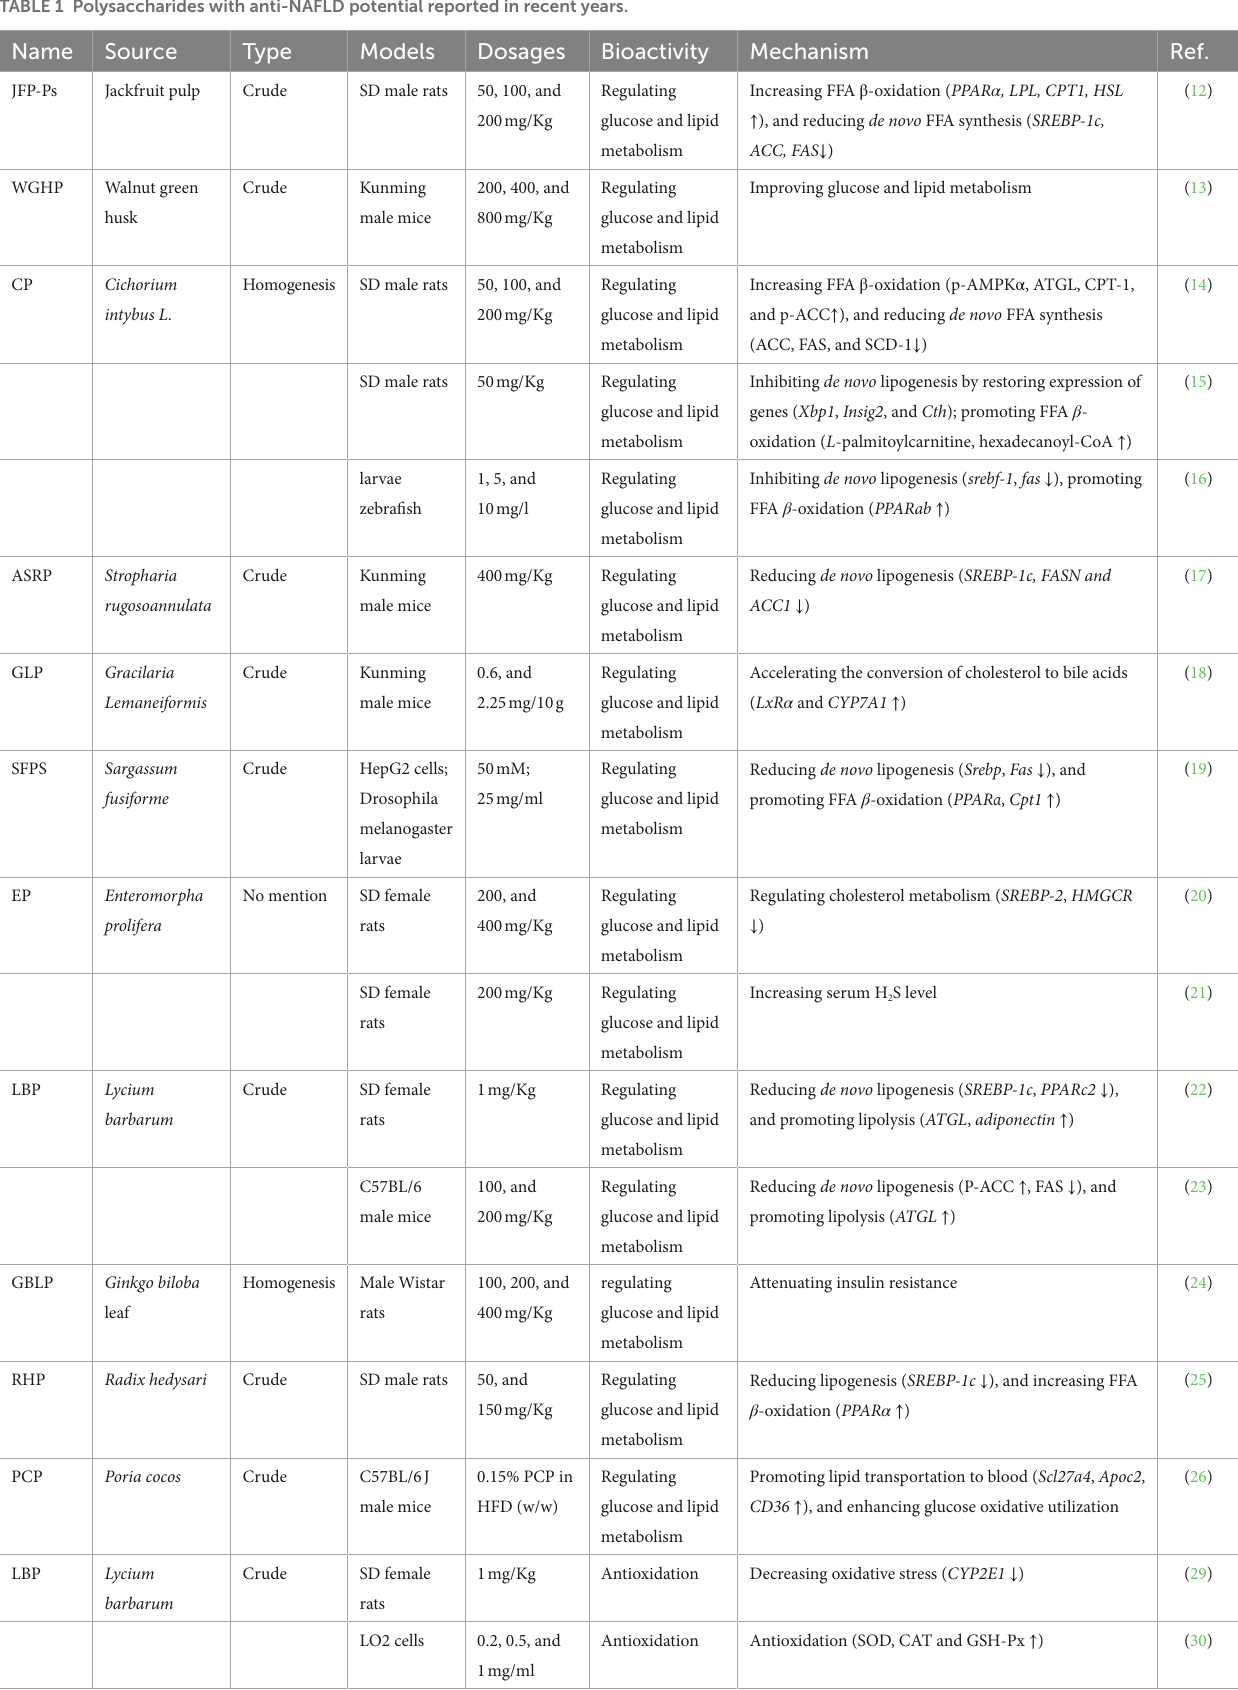
TABLE 1 Polysaccharides with anti-NAFLD potential reported in recent